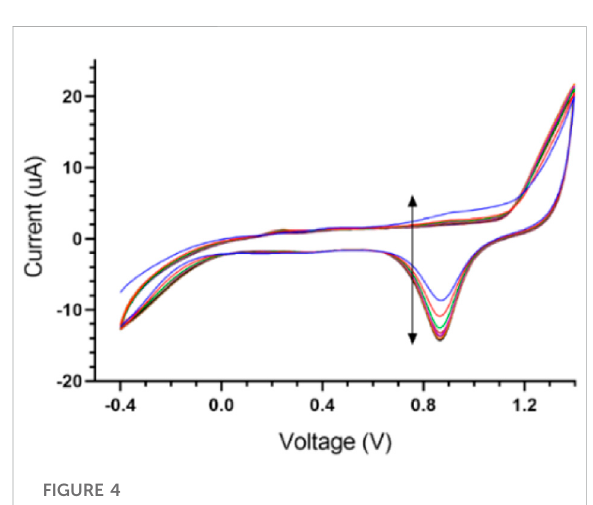
FIGURE 4 Cyclic Voltammograms of electrode cleaning in sulfuric